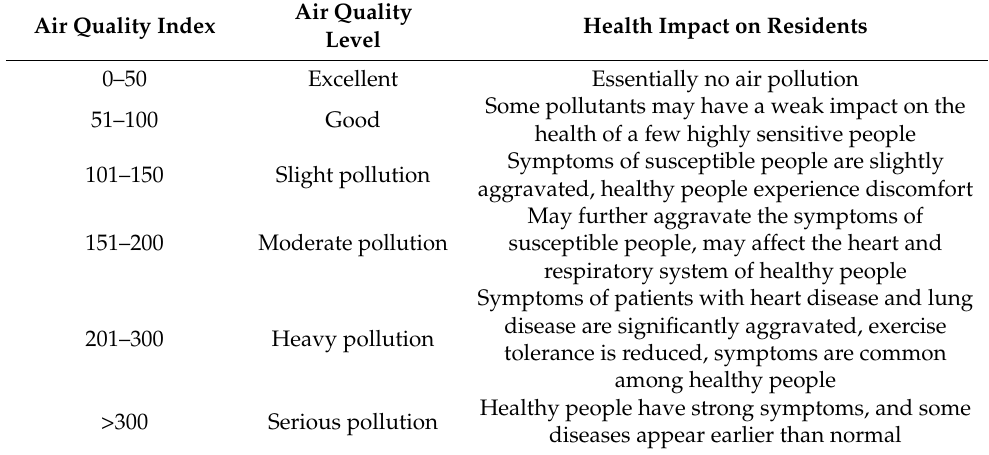
Table 9. The related description of